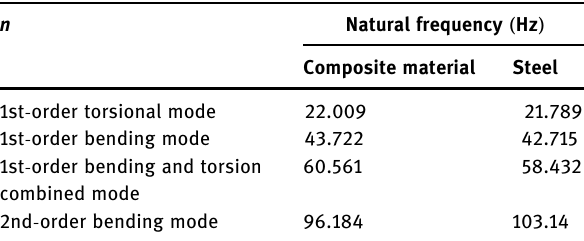
Table 3: Modal analysis results of composite fl oating rafts and steel fl